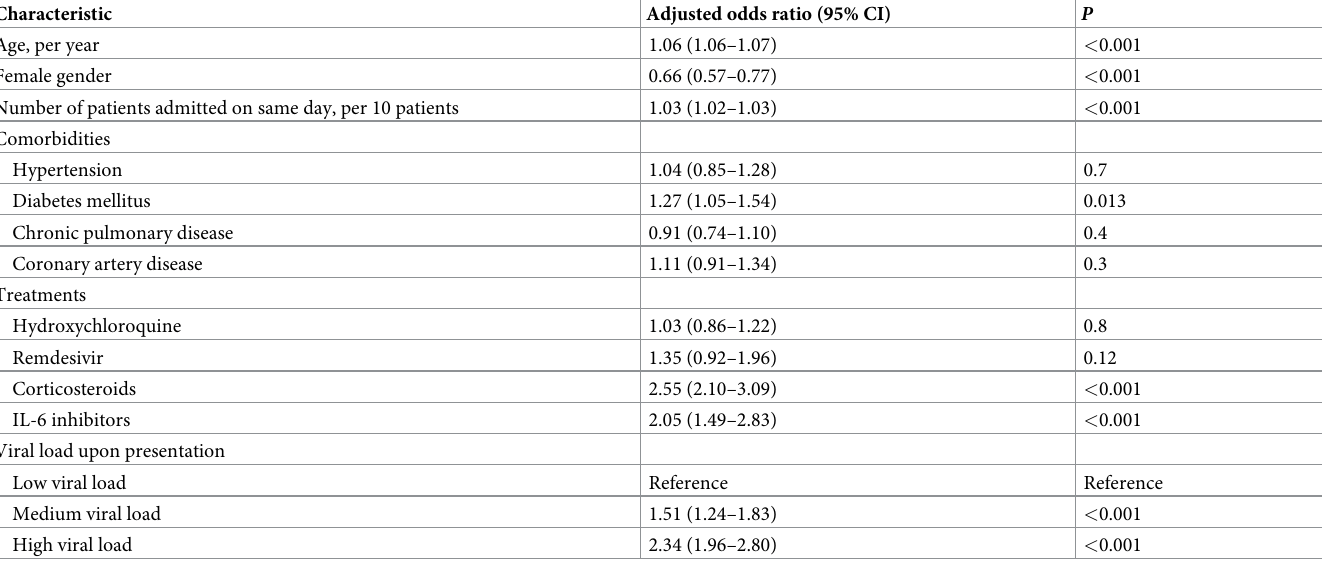
Table 1. Logistic regression model of factors associated with in-hospital mortality among patients admitted with COVID-19.